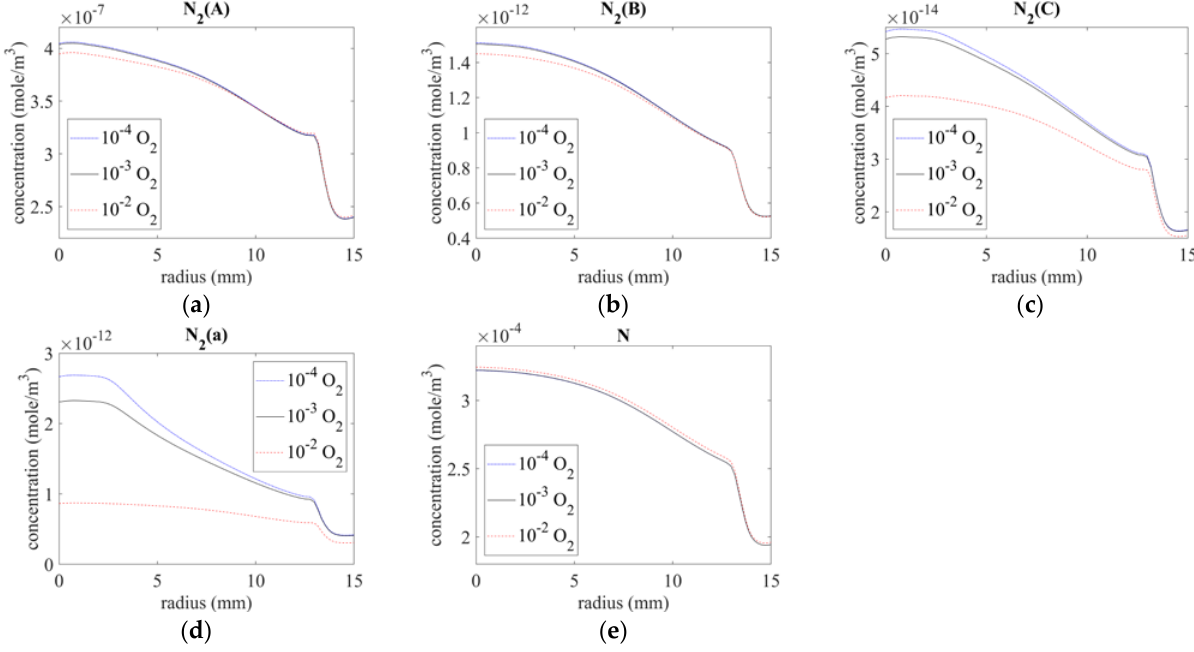
Figure 7. Species distribution on the surface of ( a ) N 2 (A), ( b ) N 2 (B), ( c ) N 2 (C), ( d ) N 2 (a), and ( e ) N.